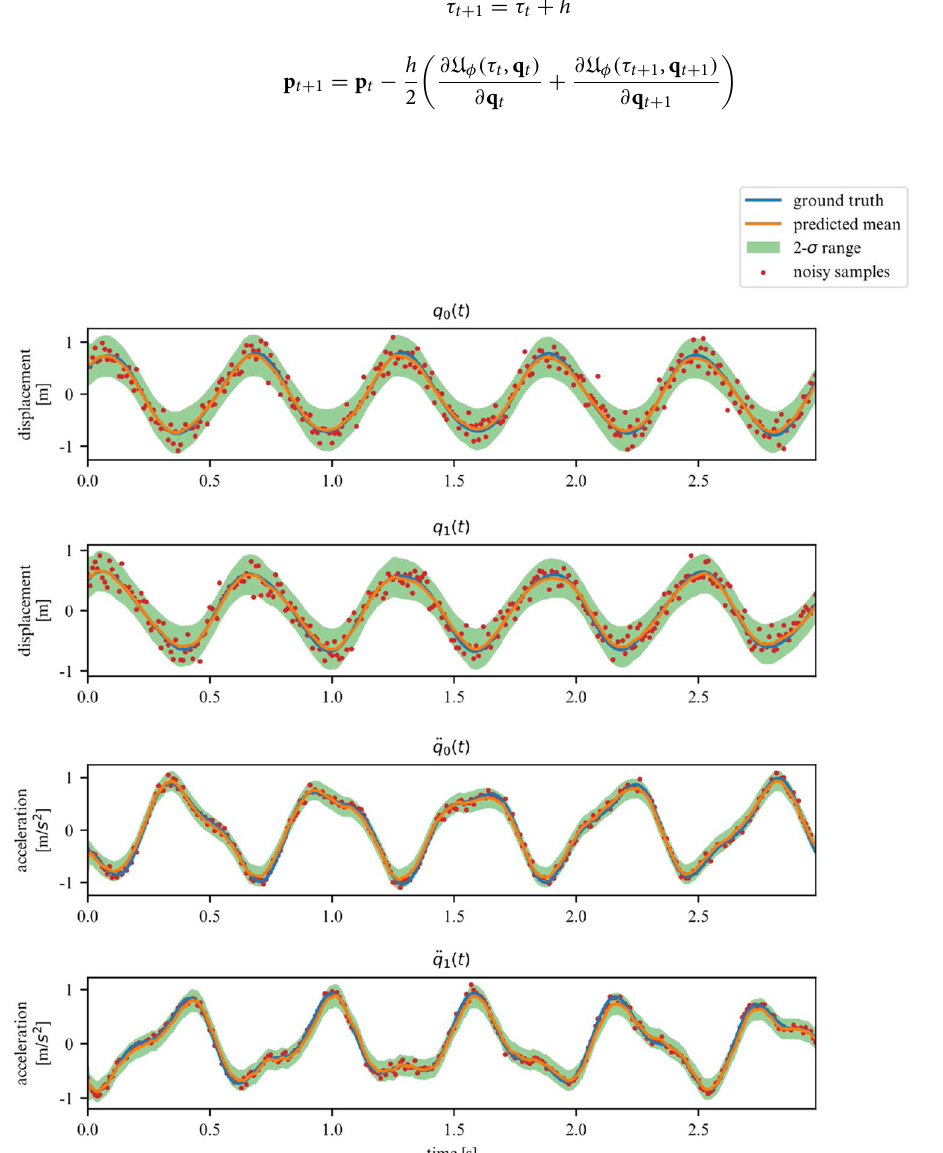
Figure 7. Observations for 2DOF